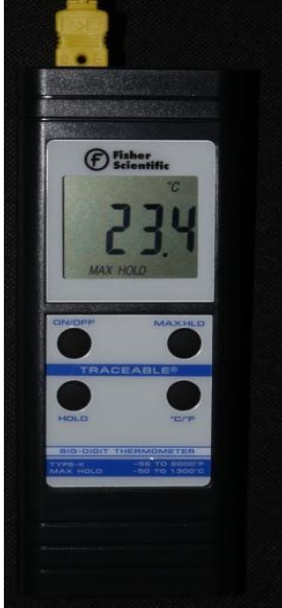
Figure 2. K-type thermocouple (Fisher Scientific 15-078-187, range − 58 to 2000 °F, resolution 0.1°/1°, sampling rate 2.5 times per second) with an ultra-fast response naked bead probe that was used to measure the temperature.